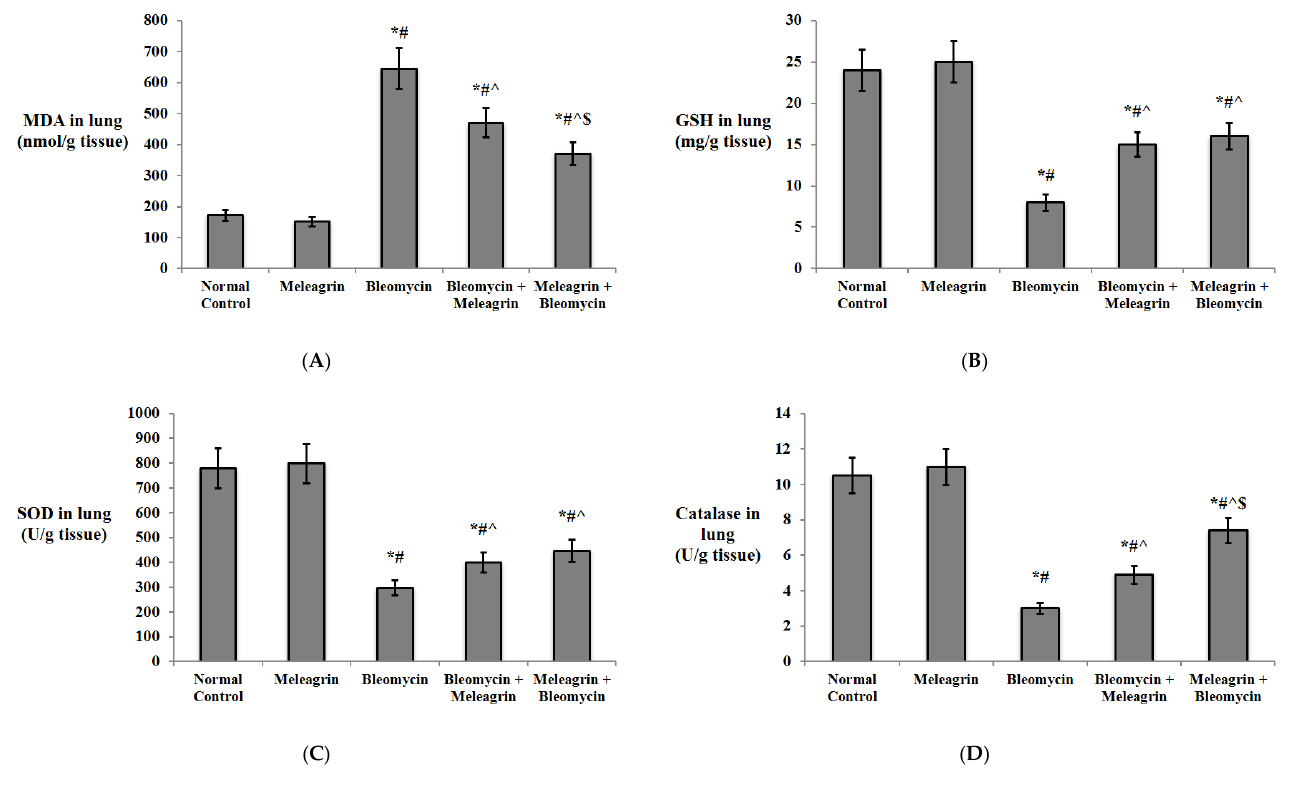
Figure 3. The effect of meleagrin on the levels of markers of oxidative stress ( A ) MDA, ( B ) GSH, ( C ) SOD and ( D ) catalase in the lung tissue of the experimental mice. MDA = malondialdehyde; GSH = reduced glutathione; SOD = superoxide dismutase. Data are expressed as mean ± SD and analyzed using one-way ANOVA followed by Bonferroni’s post hoc test ( n = 8). * significantly different vs. the normal control group; # significantly different vs. the meleagrin group; ^ significantly different vs. the bleomycin group. $ significantly different vs. the bleomycin + meleagrin group. Differences were considered significant at p < 0.05.